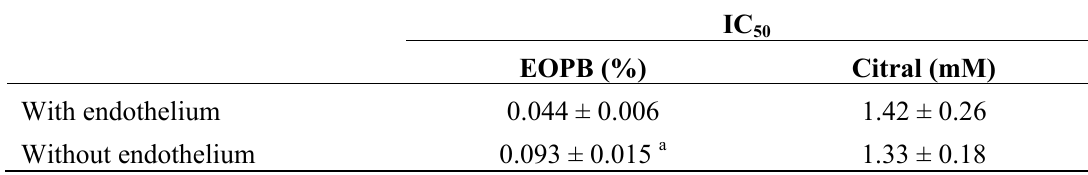
Table 2. Concentrations of essential oil of Pectis brevipedunculata (EOPB) or citral to induce 50% of the maximal relaxation (IC ) in the phenylephrine-induced contraction in 50 aortic rings from Wistar Kyoto